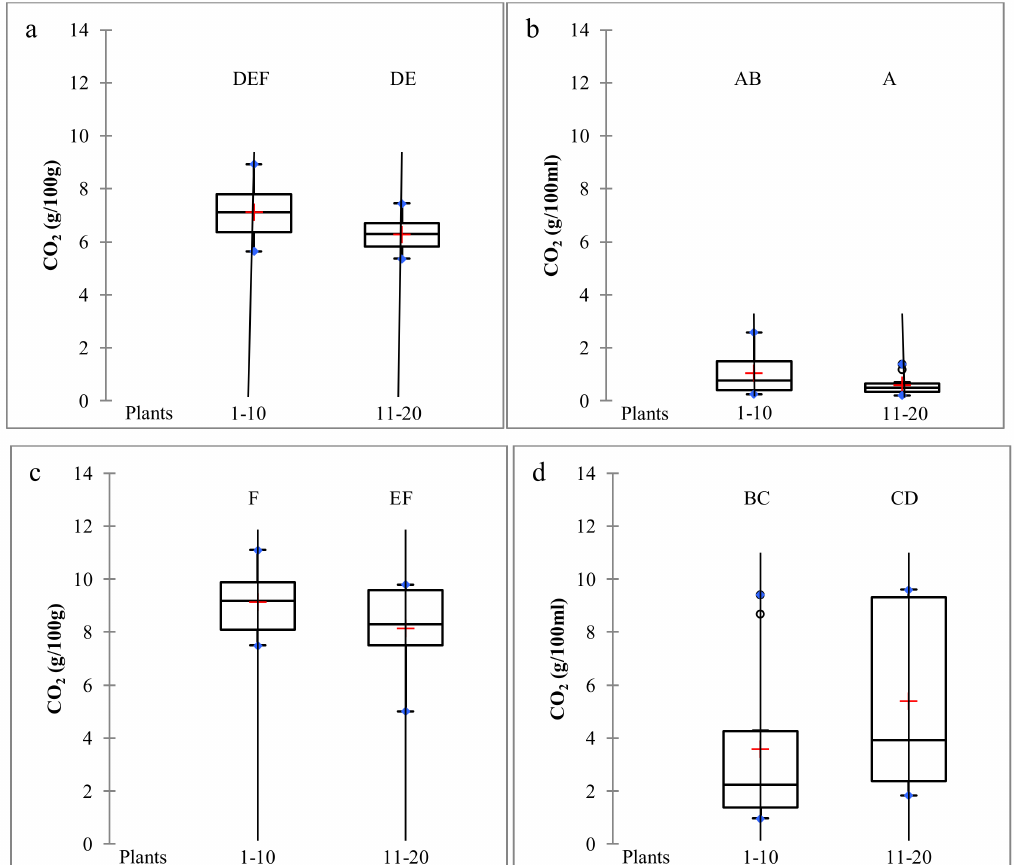
Figure 1. CO 2 production at sampling time (harvest time 1, H1) at the end of the fermentation process of grape bunches collected from the young vineyard (YV) ( a ), bark samples collected from the YV ( b ), grape bunches collected from the old vineyard (OV) ( c ), and bark collected from the OV ( d ). Di ff erent letters above the boxplots indicate significant di ff erences between the average CO 2 values calculated for the 10 plants of each row in the two vineyards, according to the Tukey’s test ( p ≤